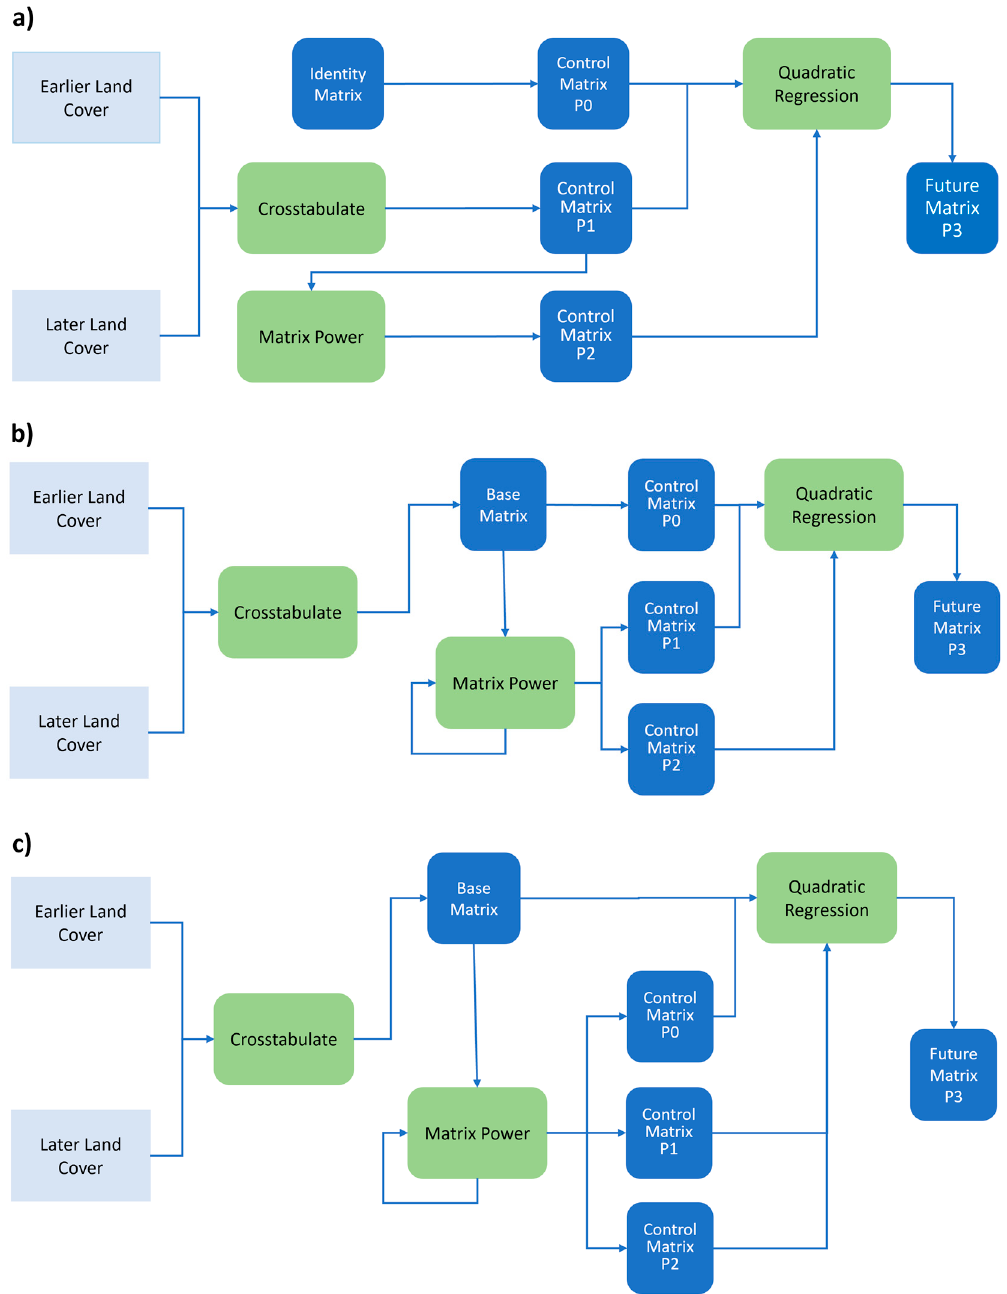
Figure 3. Schematic of the RBM algorithm for cases where the future date is between: ( a ) the present and one time step ahead, ( b ) one and two time steps ahead, and ( c ) x and x + 1 time steps ahead. The input land cover maps are shown in light blue. Analytical operations are symbolized in green. Dark blue symbols represent transition probability matrices. With this logic, the future transition probability matrix is always interpolated, using quadratic regression, between control matrices P0 and P1. Note that recursive matrix powering is required in ( b ) and ( c ) to generate control matrices.